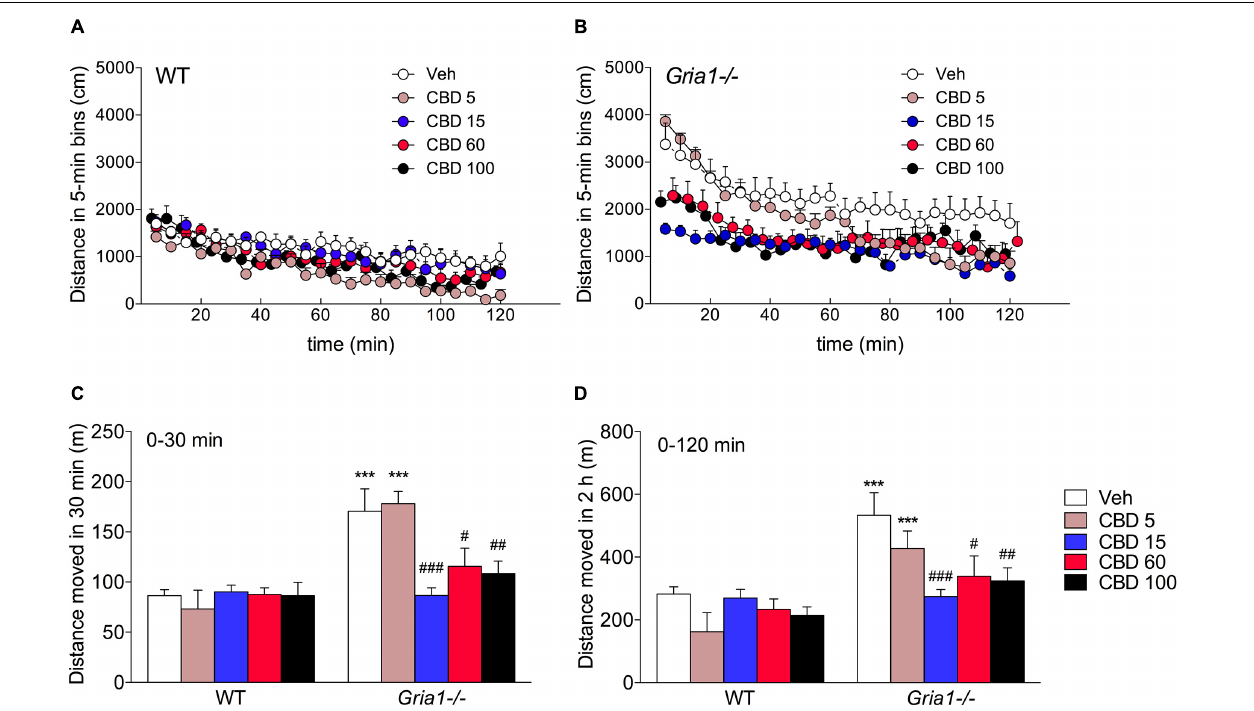
FIGURE 1 | Dose–response analysis of cannabidiol on novelty-induced hyperlocomotion of Gria1 − / − mice. (A,B) Distance traveled in a novel environment in 5-min periods after treatment with vehicle and doses of cannabidiol (mg/kg, i.p.). (C) Distance traveled from the beginning of the trial until 30 min. (D) Total distance traveled during the whole 2 h test trial. Means ± SEMs are shown for 5–6 mice per group. ∗∗∗ P < 0.001 for the significances of the differences between WT and Gria1 − / − mice after vehicle treatment; # P < 0.05, ## P < 0.01, and ### P < 0.001 between vehicle and CBD within the same genotype (Bonferroni post-test). Veh, vehicle; CBD,